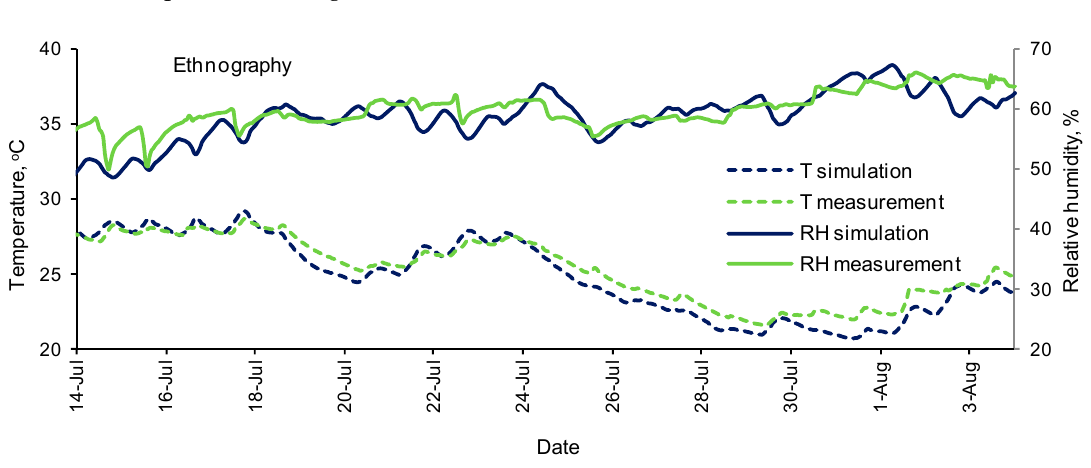
6 of 15 Table 3 . Input data to case study simulations. Component